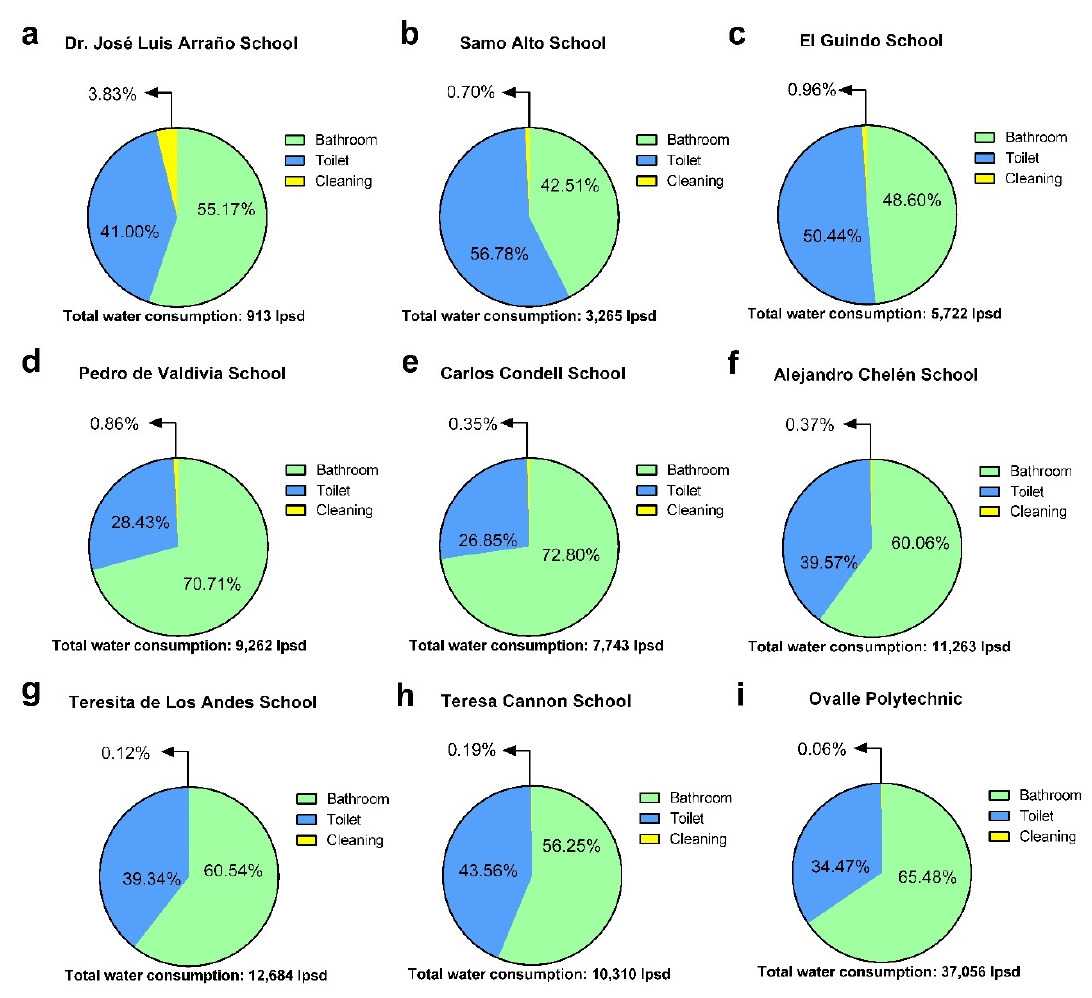
Figure 2. Water consumption in 9 schools in the Coquimbo Region. Data are presented as total consumption in liters of water per school per day (lpsd).